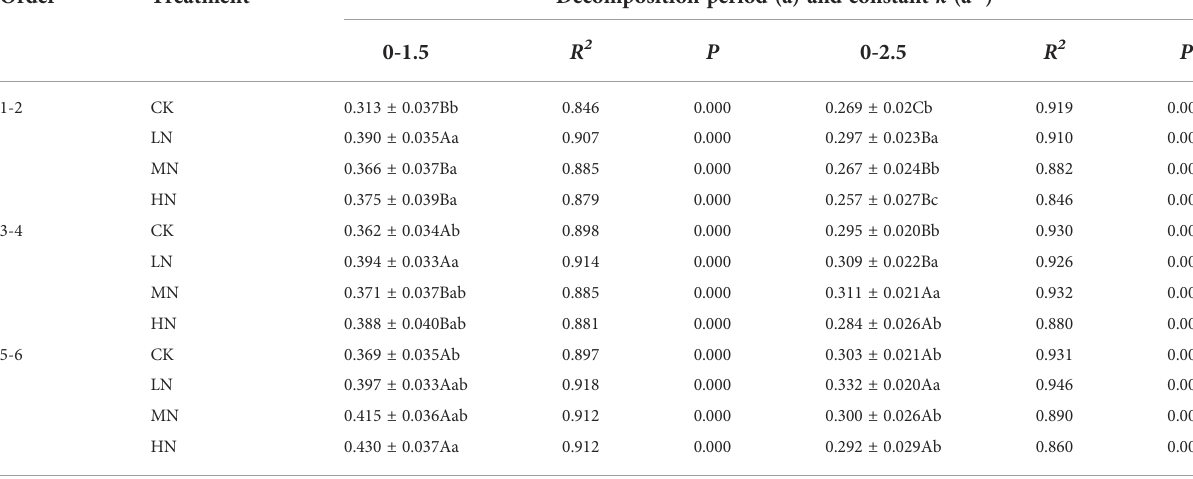
TABLE 2 Mean decomposition rates ( k ) of the three orders of roots in different N addition treatments.